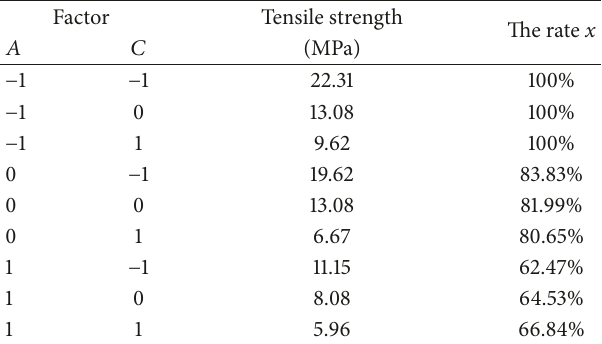
Table 4: The experiment results at different levels of layer thickness ( 𝐴 ) and air gap ( 𝐶